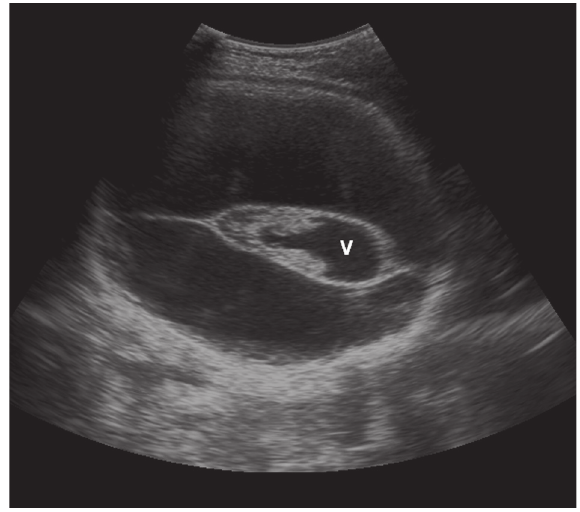
Figure 1. Prenatal ultrasound scans image of the fetus. Transabdominal transverse section of the fetal head at 38 weeks of gestation shows dilated third ventricle (V) with absent thalami and basal ganglia and cerebral cortex.